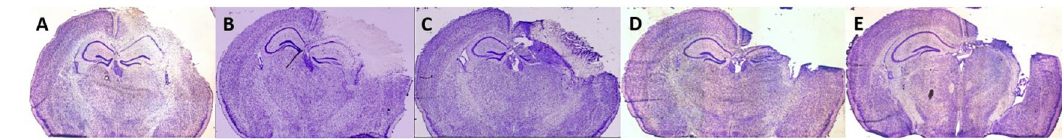
Fig 2. Examples of coronal sections on days one (A), three (B), seven (C), 14 (D) and 28 (E).